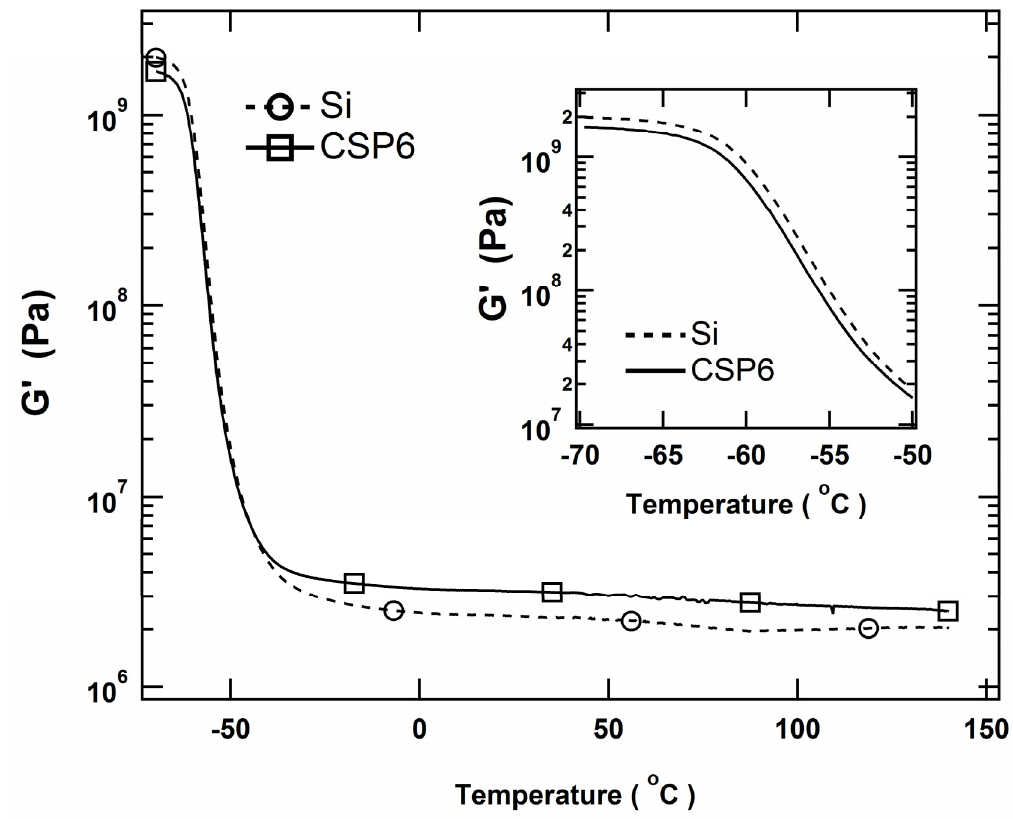
Figure 7. G’ of silica reinforced rubber and protein/CaCO 3 reinforced rubber.